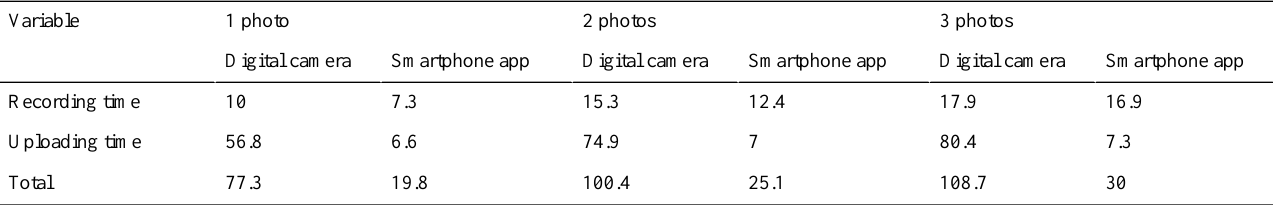
Table 4. Average time spent in each group according to the number of photos uploaded. All values represented are in